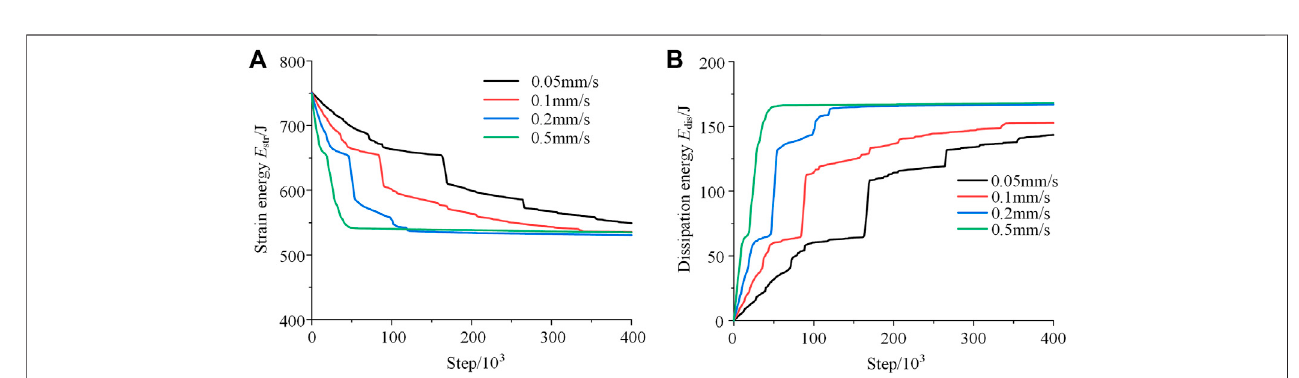
FIGURE 3 | Displacement fi eld of the specimen at step. (A) 1e4; (B) 6e4; (C) 2e5.